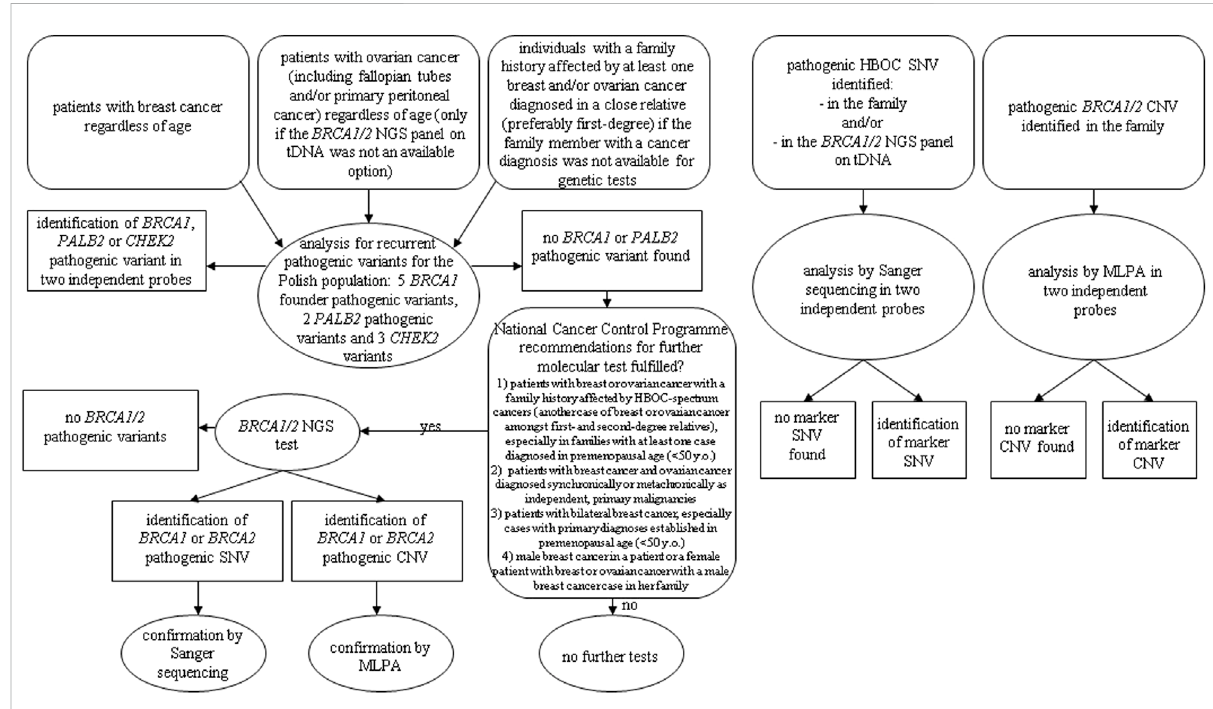
FIGURE 1 Diagnostic algorithm according to National Cancer Control Programme of the Ministry of Health for the years 2018 –